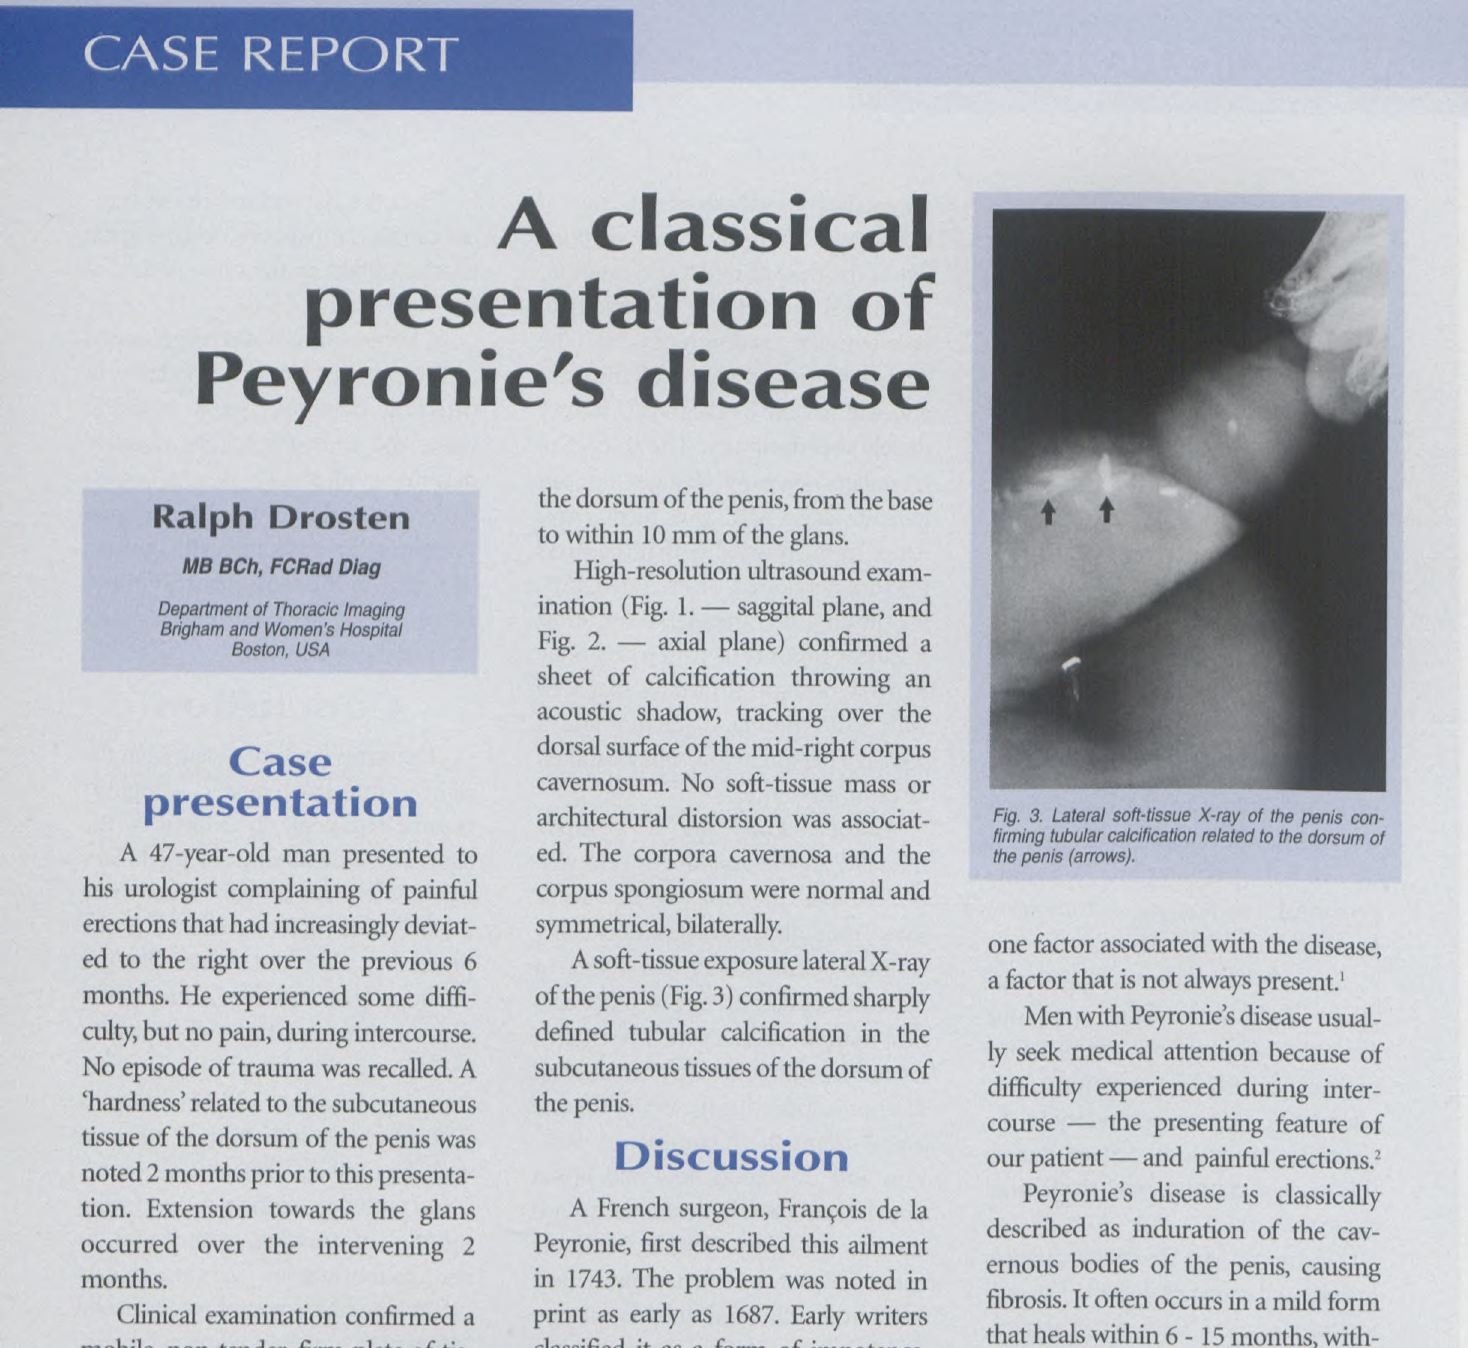
Figs 1 and 2. Saggltal and axial ultrasound Images showing tubular calcification (arrows) and associated acoustic shadow.